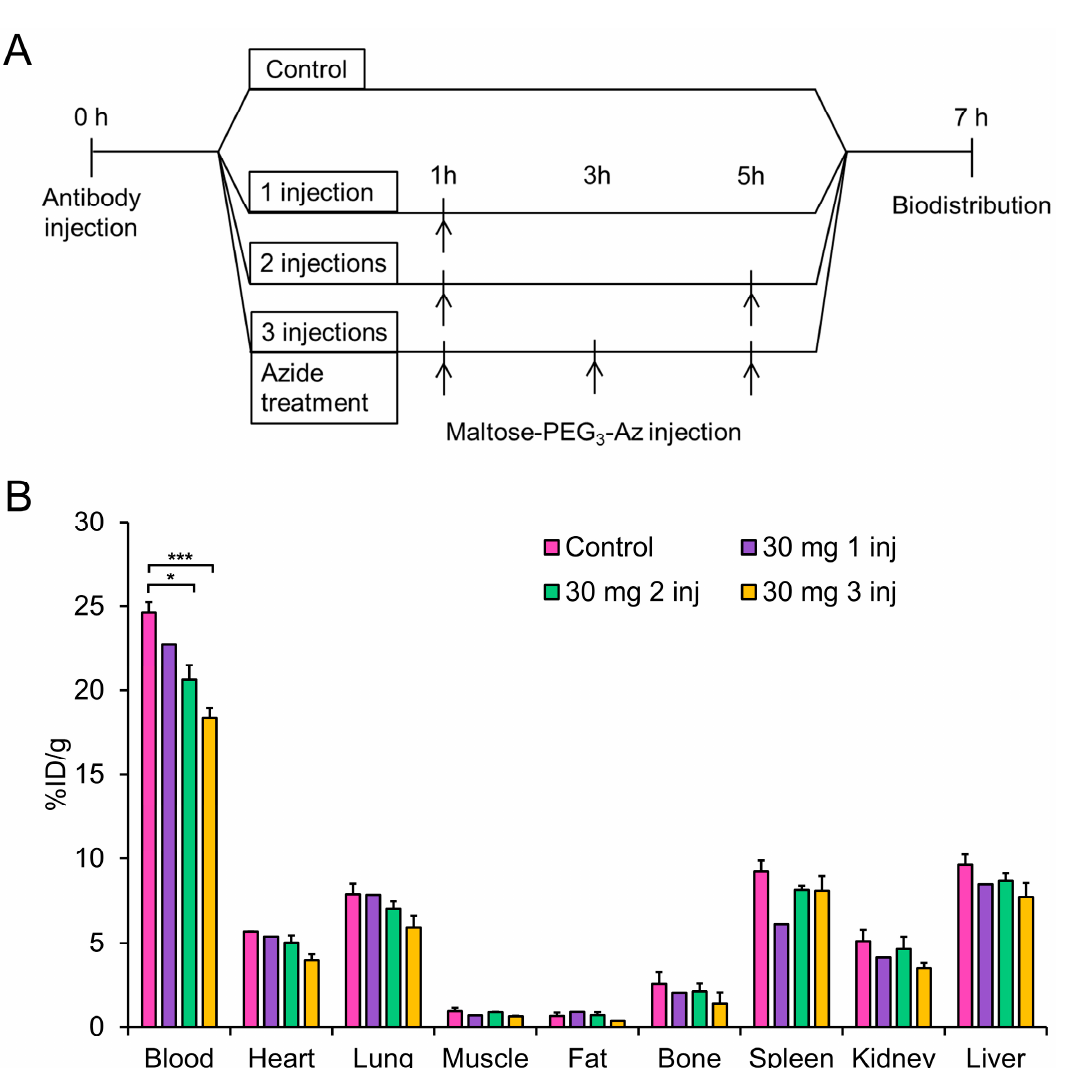
Figure 6. A schematic representation demonstrating the injection of radiolabeled antibody followed by maltose-PEG 3 -azide and finally biodistribution ( A ). Biodistribution data of ICR mice after injection of [ 131 I]DPTA-trastuzumab followed by changing the number of maltose-PEG 3 -azide injections ( B ) (n = 2). * p < 0.05 and *** p < 0.001.